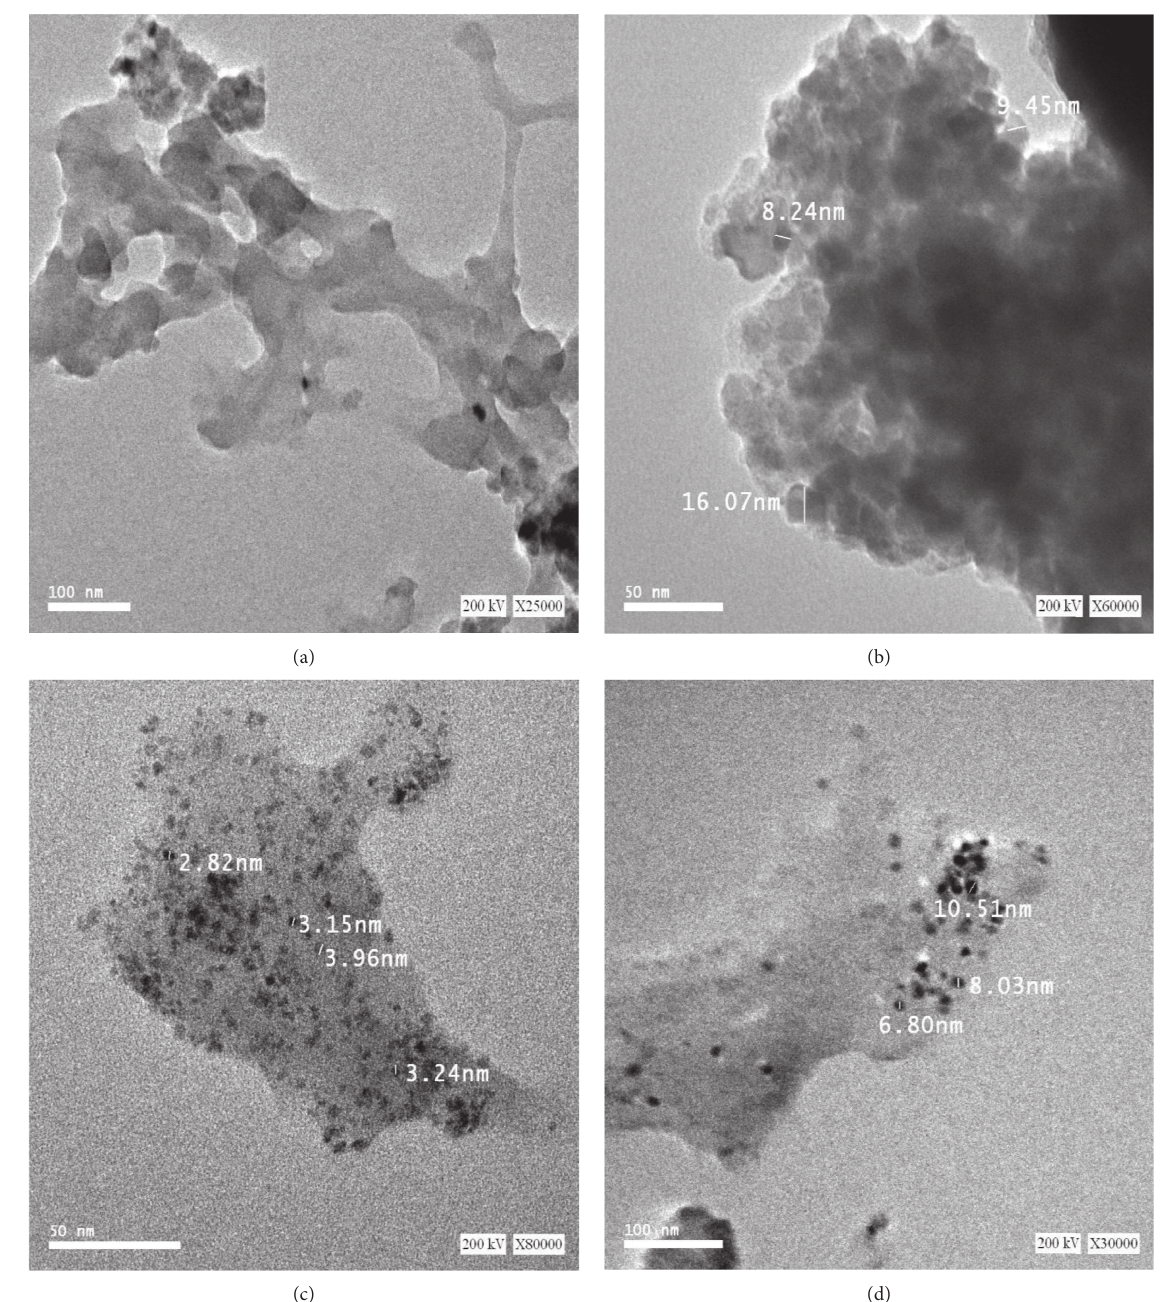
Figure 4: TEM images of (a) Chitosan, (b) CGPNMA, (c) CGP2MA, and (d)